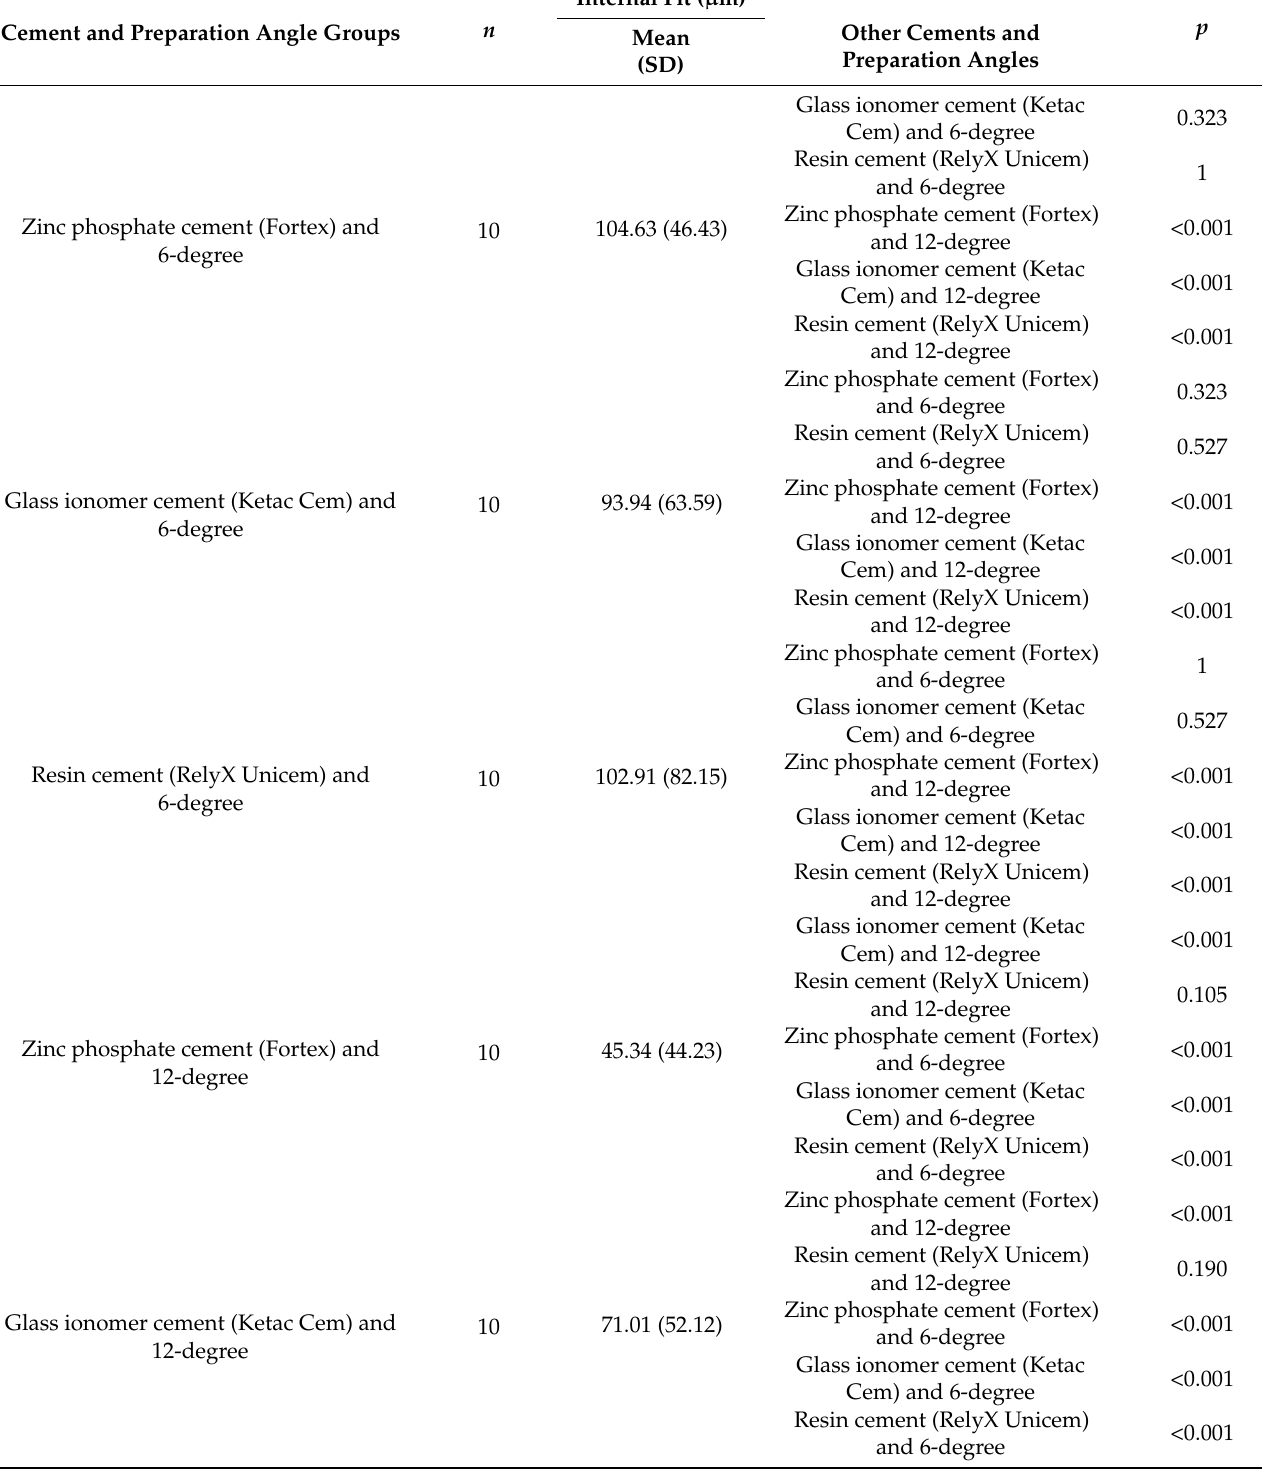
Table 3. Internal fit according to the cement used and the preparation angle. SD: standard deviation.